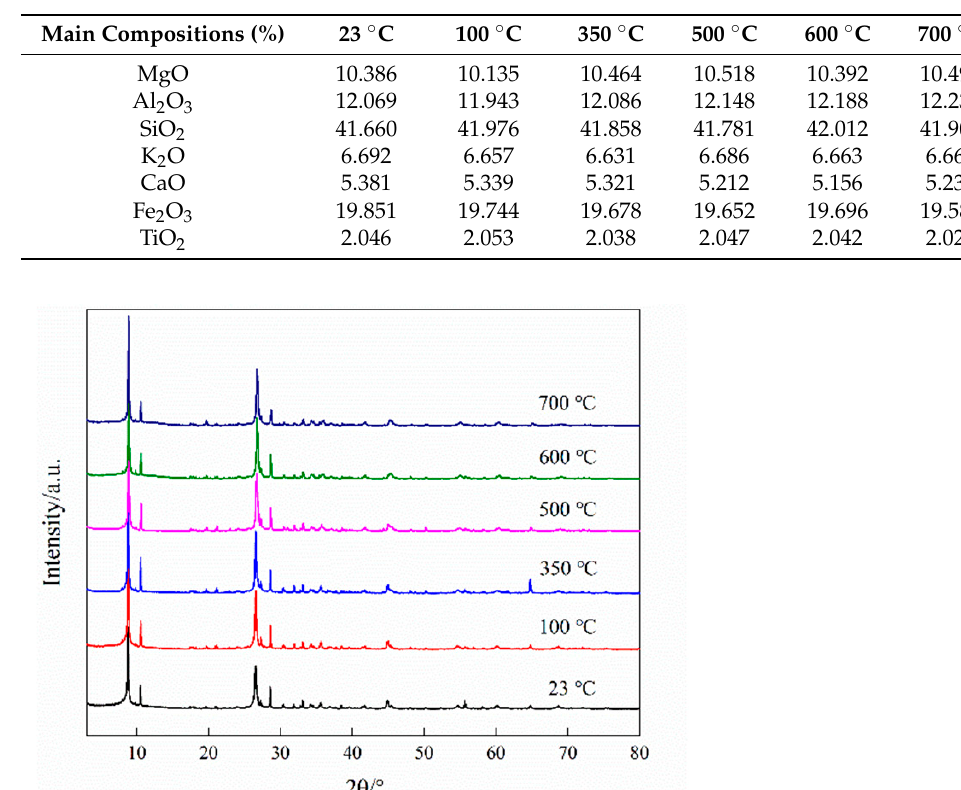
Table 2. XRF results about main compositions of Lapis Chloriti samples at different temperatures.